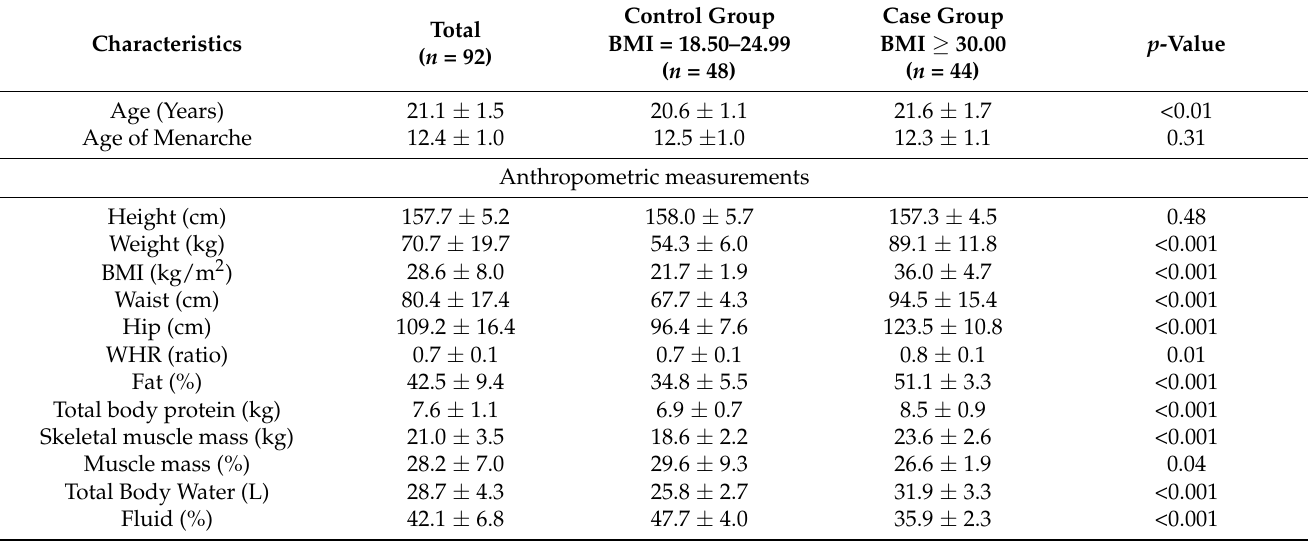
Table 1. General characteristics of the studied population 1 . Body mass index (BMI), waist-to-hip ratio (WHR), fasting blood glucose (FBG), high-density lipoprotein (HDL), low-density lipoprotein (LDL), Homeostatic Model Assessment for Insulin Resistance (HOMA-IR), and the homeostasis model assessment of β -cell function (HOMA- β